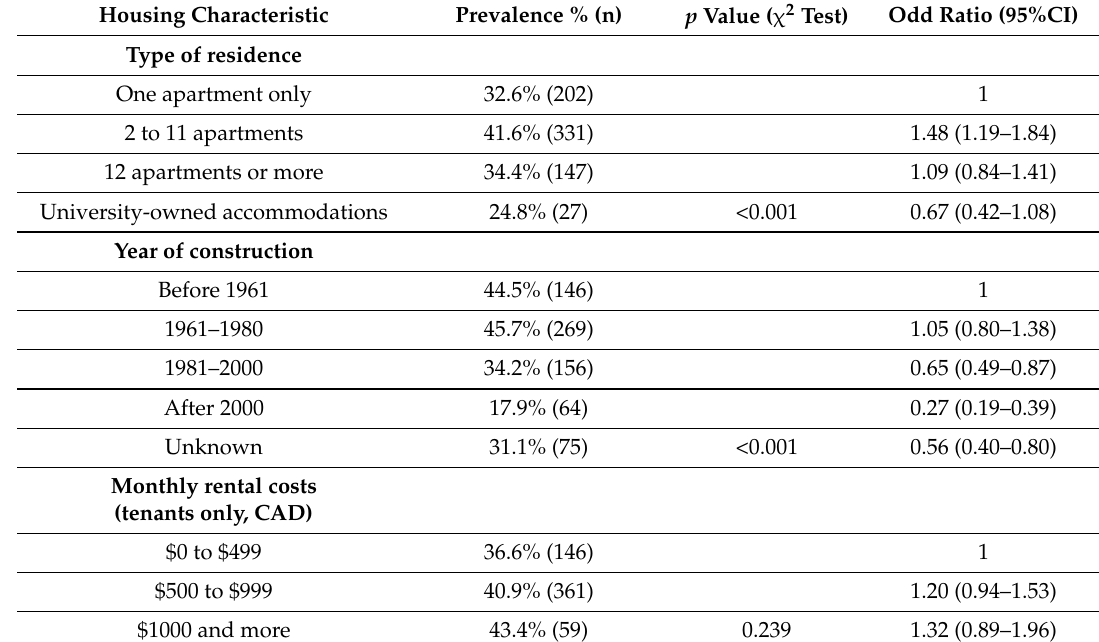
Table 3. Prevalence of residential dampness or mold per housing characteristics, Université de Sherbrooke students (QC, Canada), winter